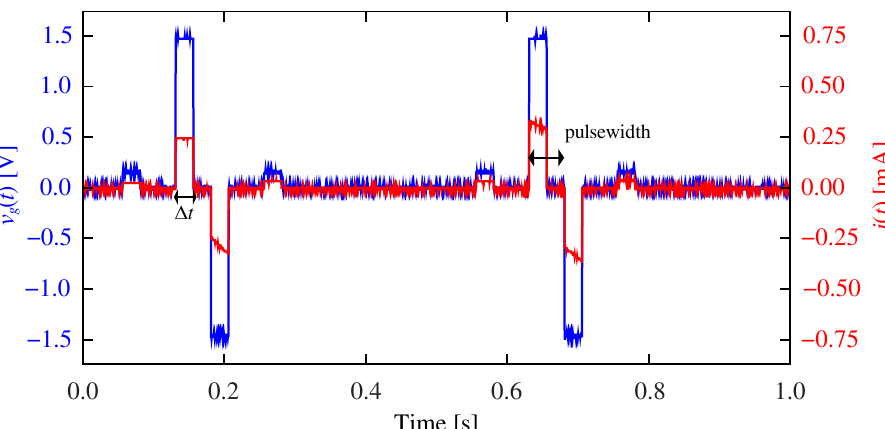
Figure 5. Driving signal v g and current i flowing through the emulator. Two 50 ms-wide and 1.5 V-high stimulus pulses and two 25 ms-wide and 200 mV-high measurement pulses comprise each period. In this example, ∆ t = 25 ms and the pre and postynaptic stimuli overlap for 25 ms. Parameters: